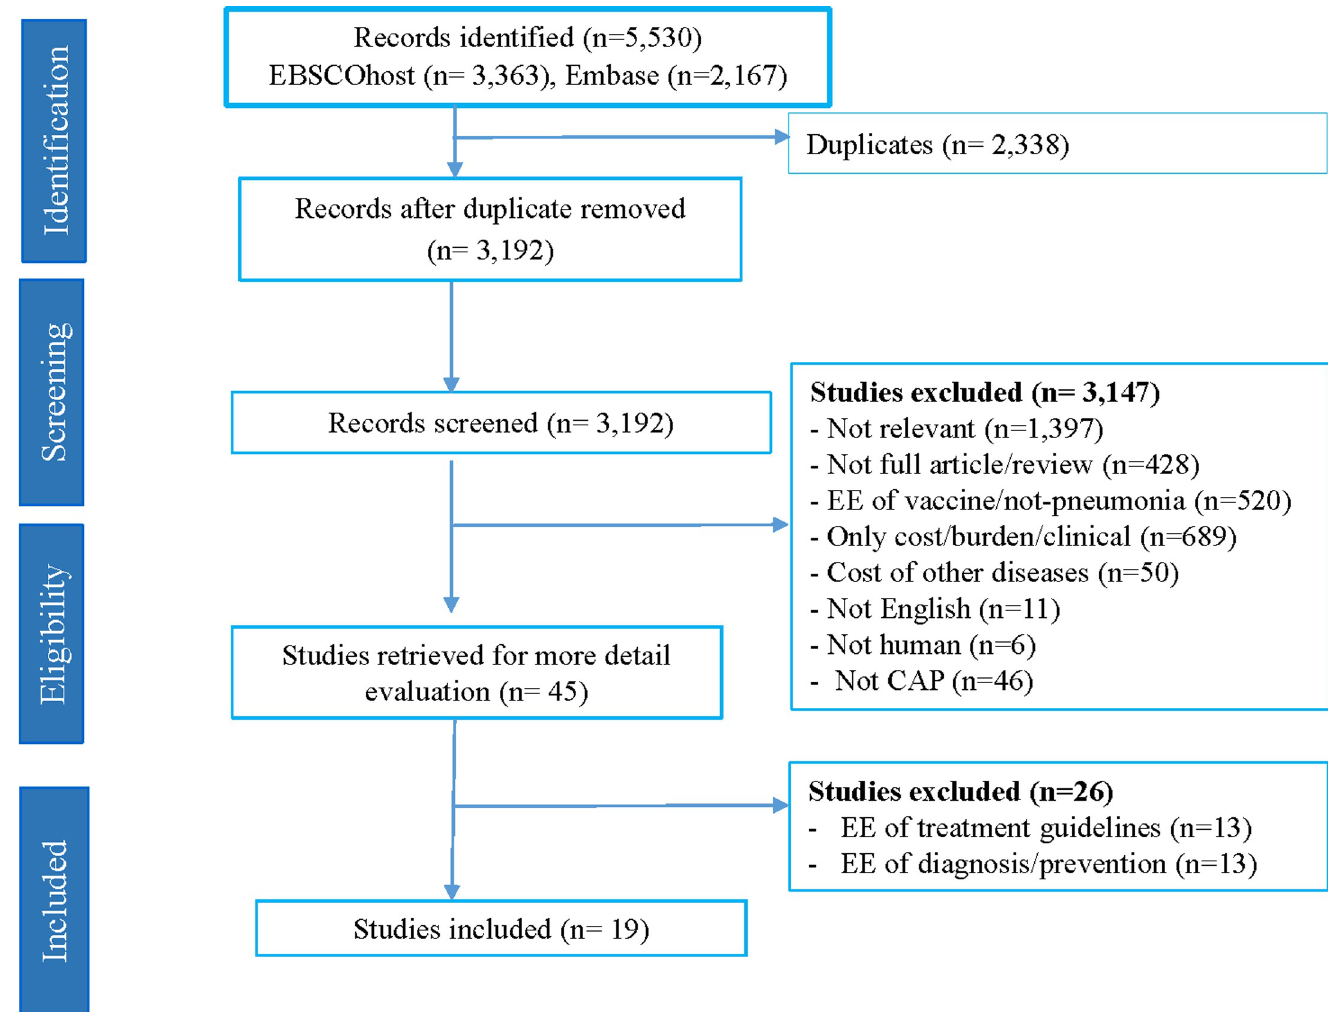
Fig 1. Flow chart of literature search (PRISMA) for economic evaluation studies.